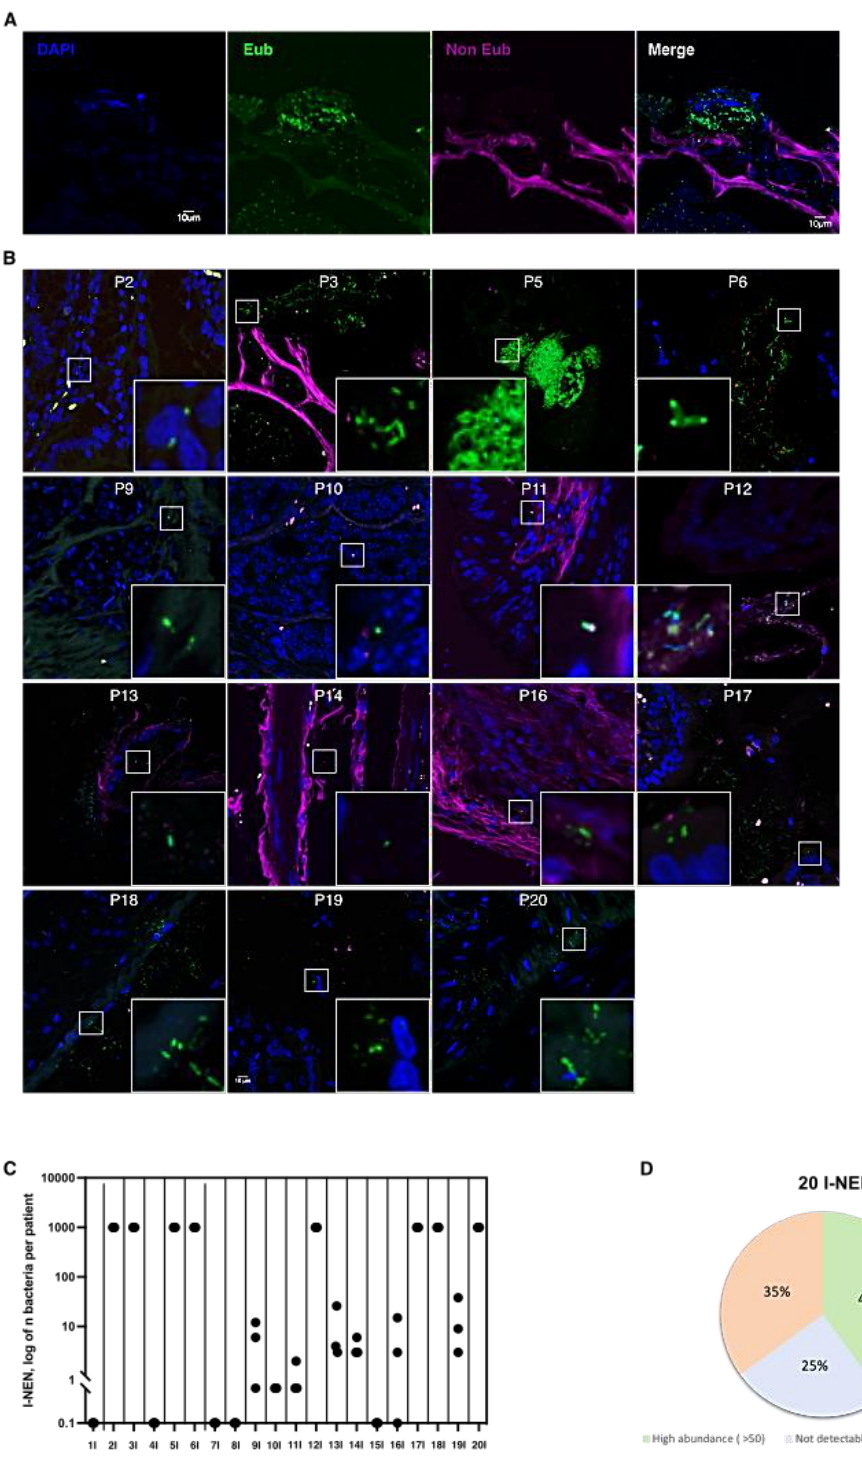
Figure 1. Bacterial count in I-NEN patients. ( A ) Confocal microscopy images of single optical sections showing the DAPI, Eub (Alexa 488), non-Eub (Cyanine-5) fluorescence signals that are merged together. ( B ) Representative confocal microscopy images of the bacterial signal observed within I-NEN patients (N= 15). Scale bar = 10 µm. ( C ) Dot plot representing the log10 normalized bacterial counts per acquired section (N = 3) by FISH in I-NEN specimens (N= 20). ( D ) Distribution of bacterial occurrence in I-NEN patients (N = 20).